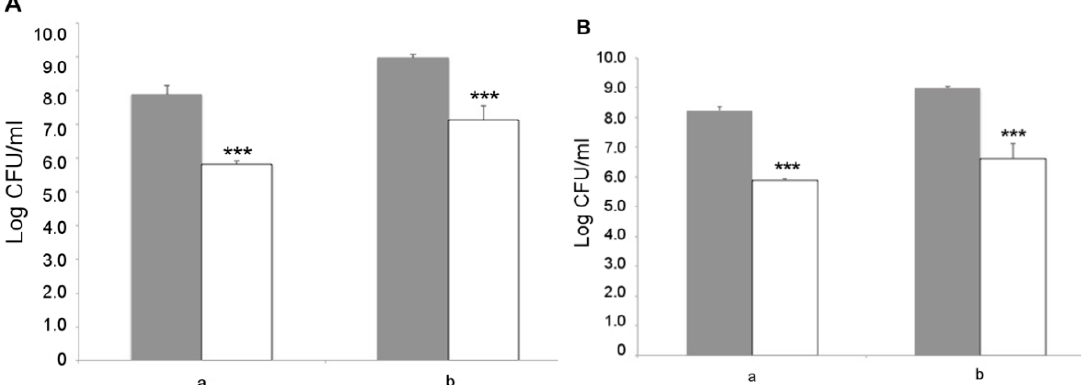
Figure 8. In vitro tolerance to simulated gastro-intestinal conditions. Cell counts of viable L. fermentum MBC2 recovered at the initial time point (t0), following 1h incubation in Simulated Gastric Juice (SGJ) and at the end of 2h incubation in Simulated Pancreatic Juice (SPJ). Data are reported as log of bacterial CFU recovered after plating. Columns represent the mean ± SD of two independent experiments, each performed in triplicate. Statistical analysis was performed by one-way ANOVA, followed by post-hoc Tukey honestly significant difference (HSD) test. Asterisks indicate significant differences (*** p < 0.001).